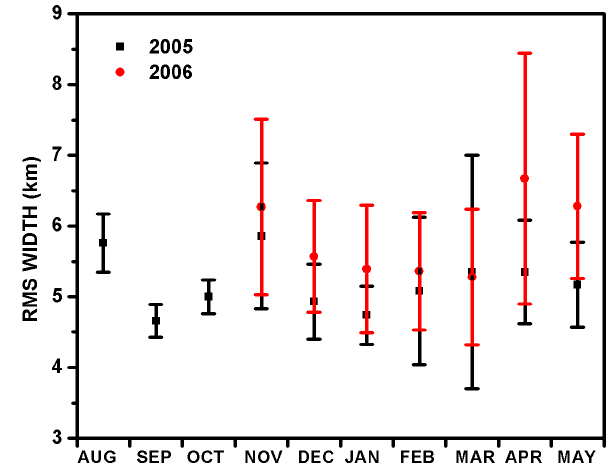
Fig. 7a. Monthly mean Sodium layer column abundance obtained during the years 2005 and 2006.